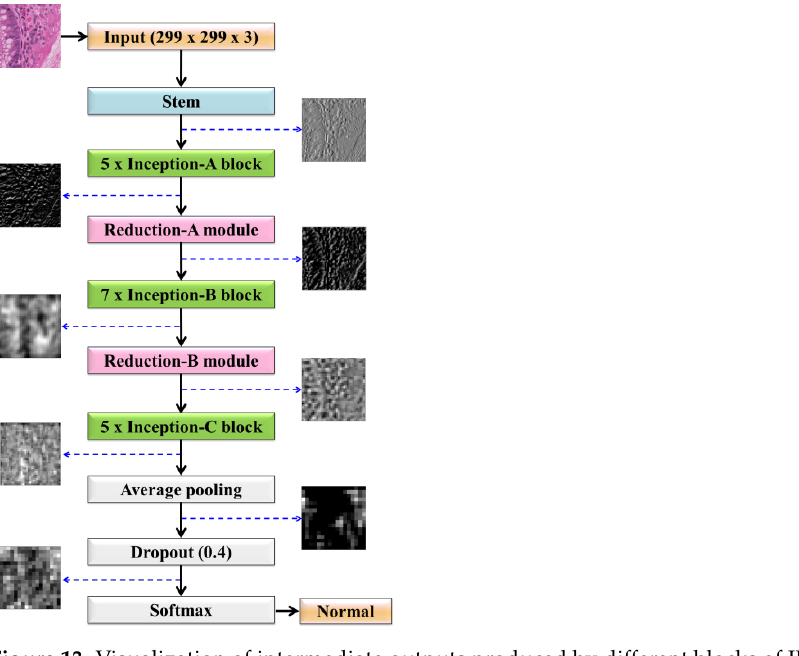
Figure 13. Visualization of intermediate outputs produced by different blocks of IR-v2 Type 5.